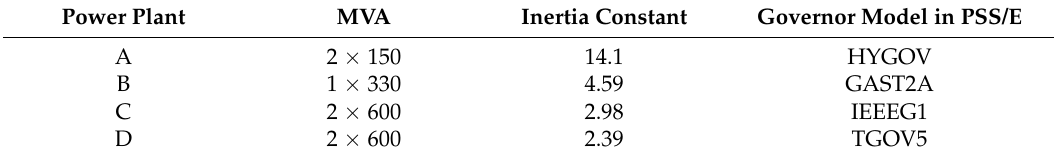
Table 1. Generator data.